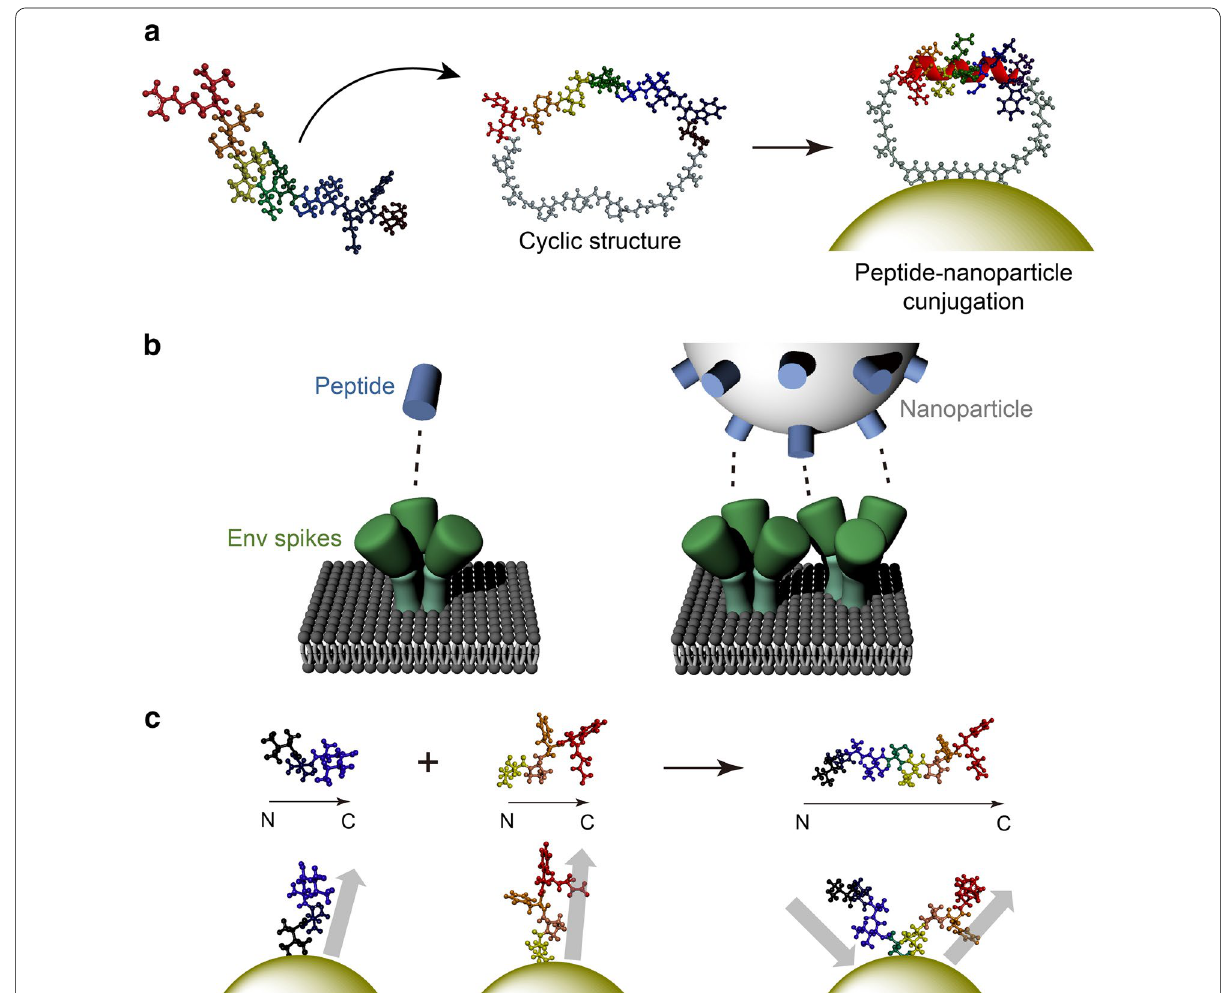
Fig. 3 a Molecular models depicting gold nanoparticle binding‑induced stabilization of α‑helical structure. b Interactions of free peptides and peptide–nanoparticle conjugates with HIV‑1 spike proteins. c Peptide hybrid‑functionalized gold nanoparticles inhibiting amyloid‑β